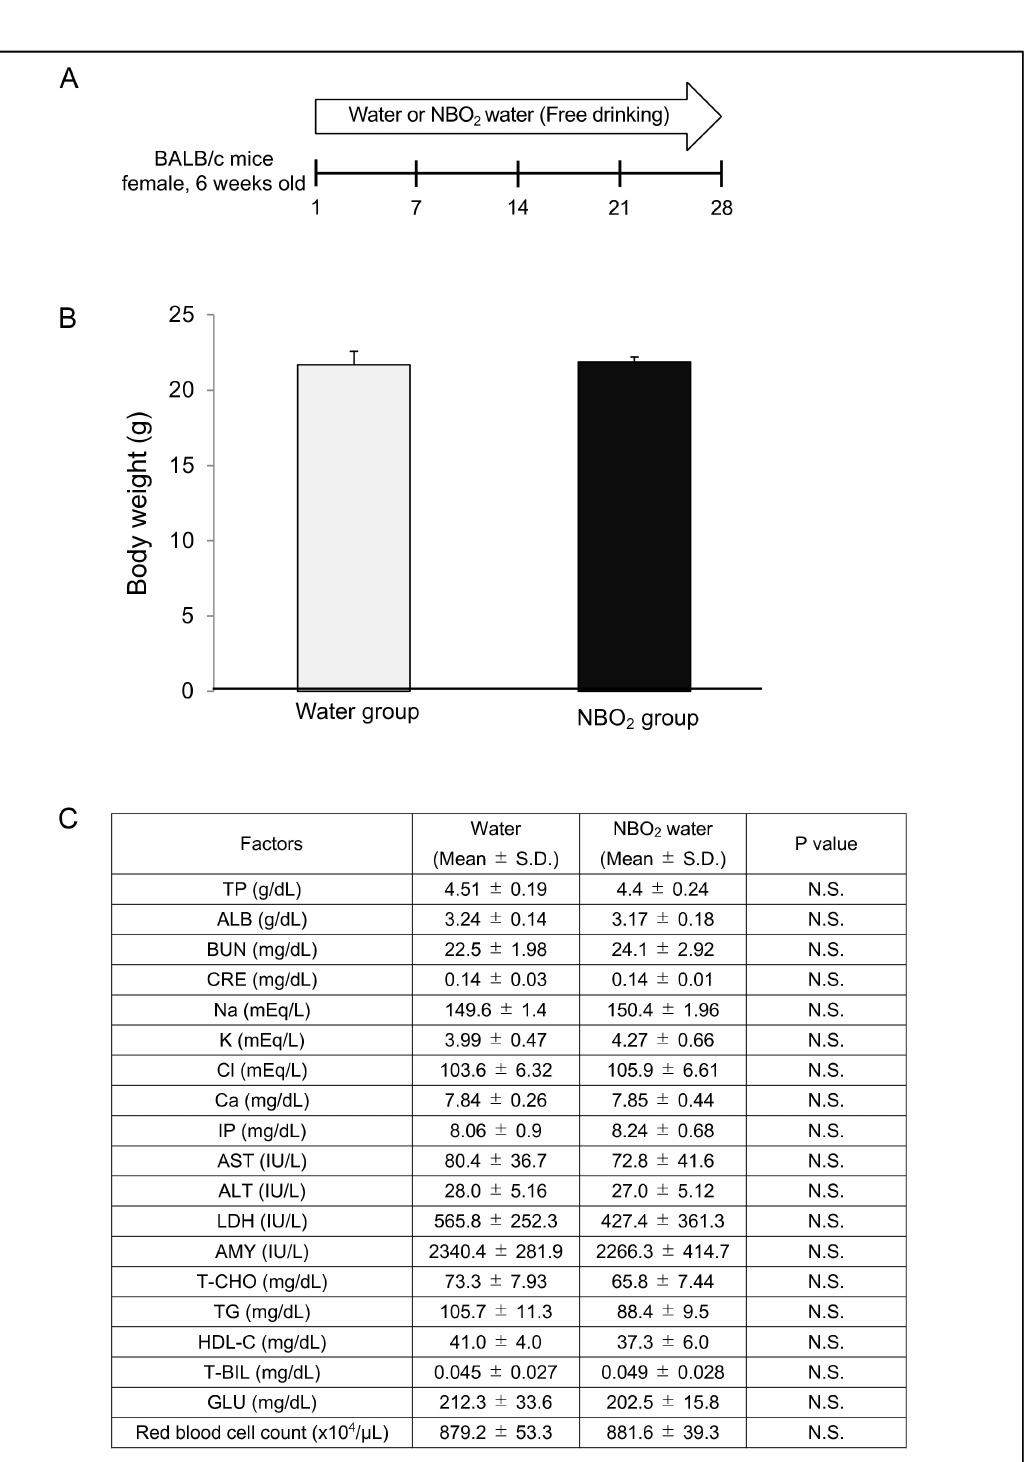
Figure 2. Safety of NBO 2 water in mice. ( A ) Schedule of this study. Oral intake of water and NBO 2 water in BALB/c mice was carried out from day 1 to day 28. Blood samples were harvested at day 28. ( B ) The body weight of the mice in water ( n = 7) and NBO 2 water ( n = 10) groups at day 28. ( C ) Serum biochemical examinations and red-blood-cell count in blood from BALB/c mice treated with water ( n = 7) and NBO 2 water ( n = 10) over 28